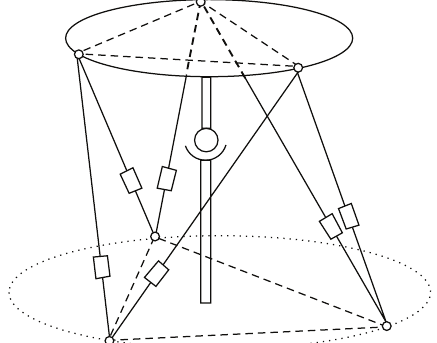
Figure 3: Hexasphere kinematical structure.